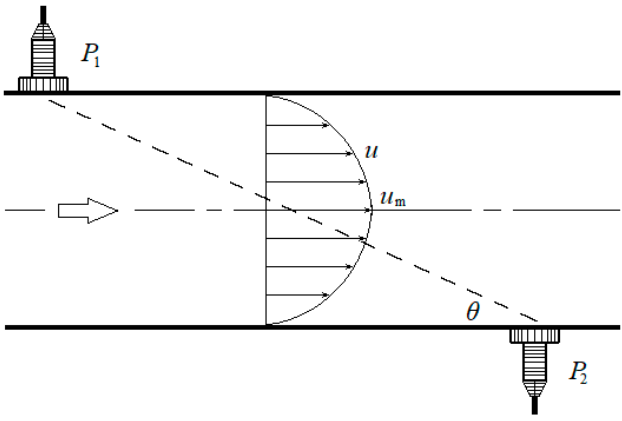
Figure 2. Principle of the transit-time ultrasonic flowmeter.